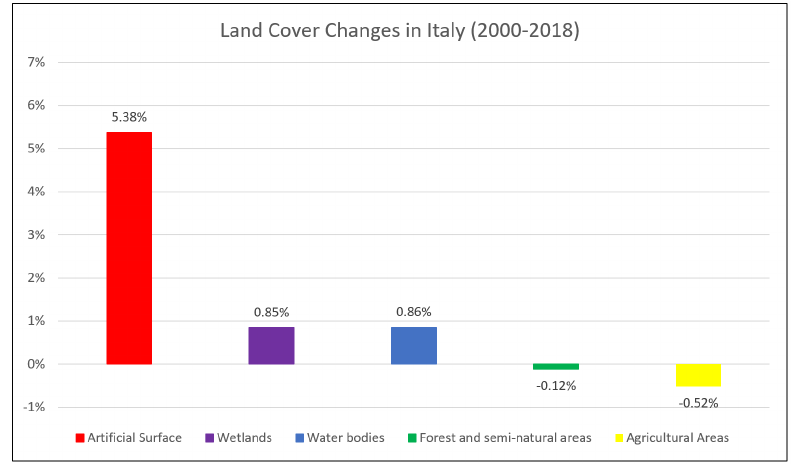
Figure 6. Land cover changes in Italy between 2000 and 2018.